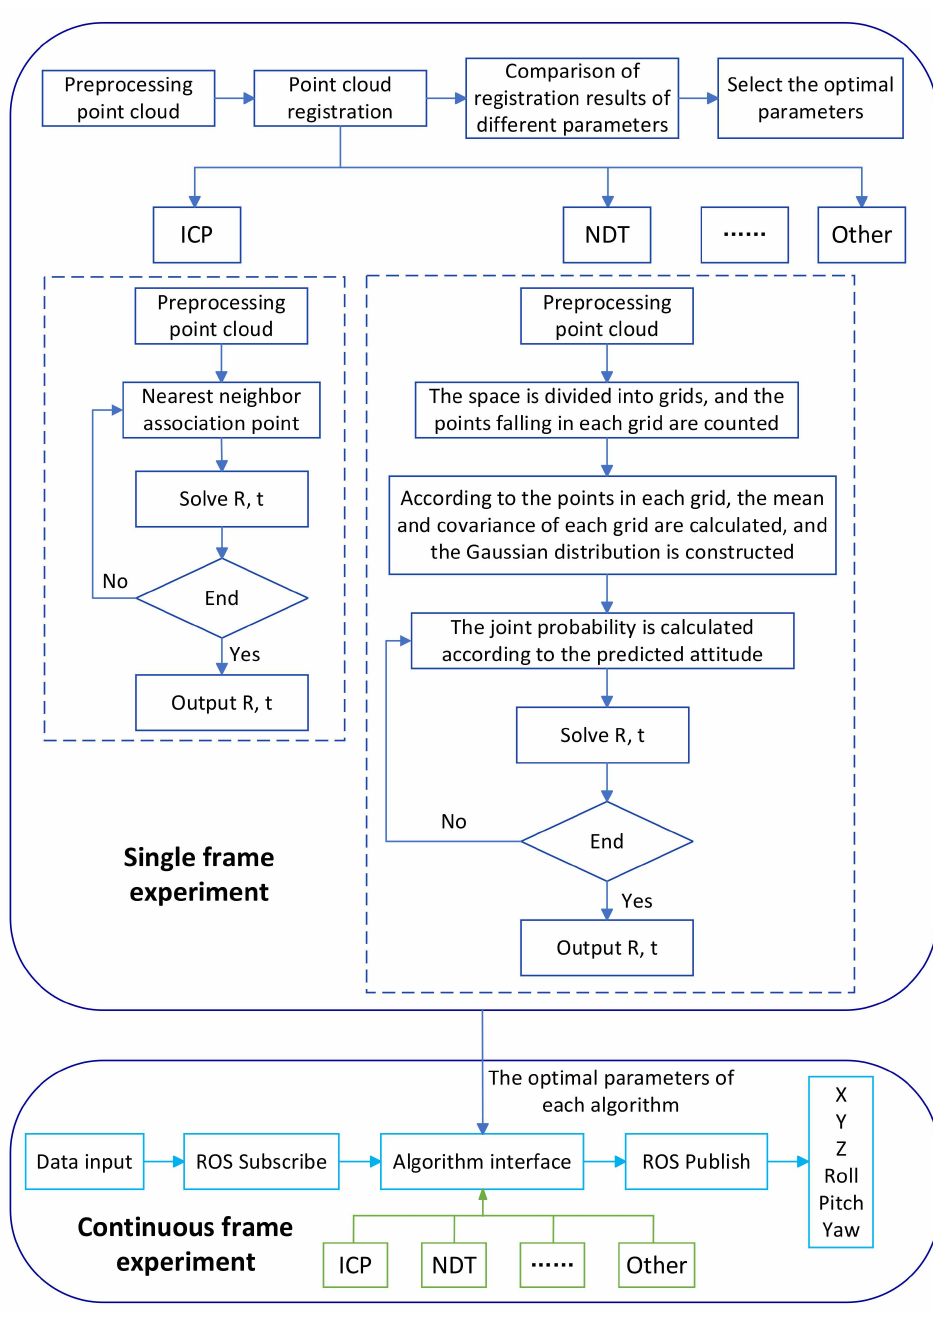
Figure 1. The whole process of